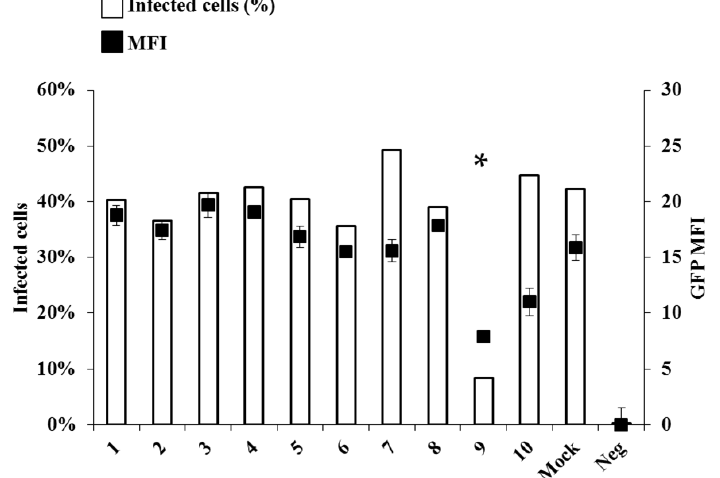
Figure 1. Screening of antiviral compounds against Ebola virus (EBOV). Vero E6 cells were infected with EBOV expressing GFP (EBOV/GFP) at an multiplicity of infection (MOI) of 0.1 in the presence of different chemical compounds (see Table 1) at the indicated concentration. Forty-eight hours afterwards, cells were detached from the plate with trypsin and fixed for 20 min with 3% PBS buffered paraformaldehyde prior to flow cytometry analysis on a Beckman Coulter Gallios apparatus (Beckman, Brea, CA, USA). Neg value indicate the background level in the non infected condition. The graph presents both the % of GFP-positive cells, reflecting the extent of viral spread and the median fluorescence intensity (MFI), simulating the level of viral transcription. All data represents averages and SEM of three independent experiments. (Please replace by: All data represents averages and SD of three independent experiments. * A student test was performed between value of compound 9 and the Mock treated condition, p -value below 0.05. The data are representative of the values of two different experiments performed in triplicate).